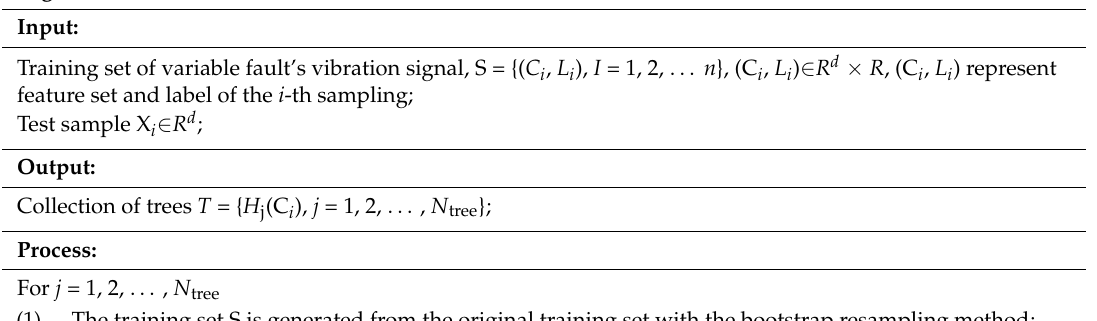
Algorithm 1. Random Forest